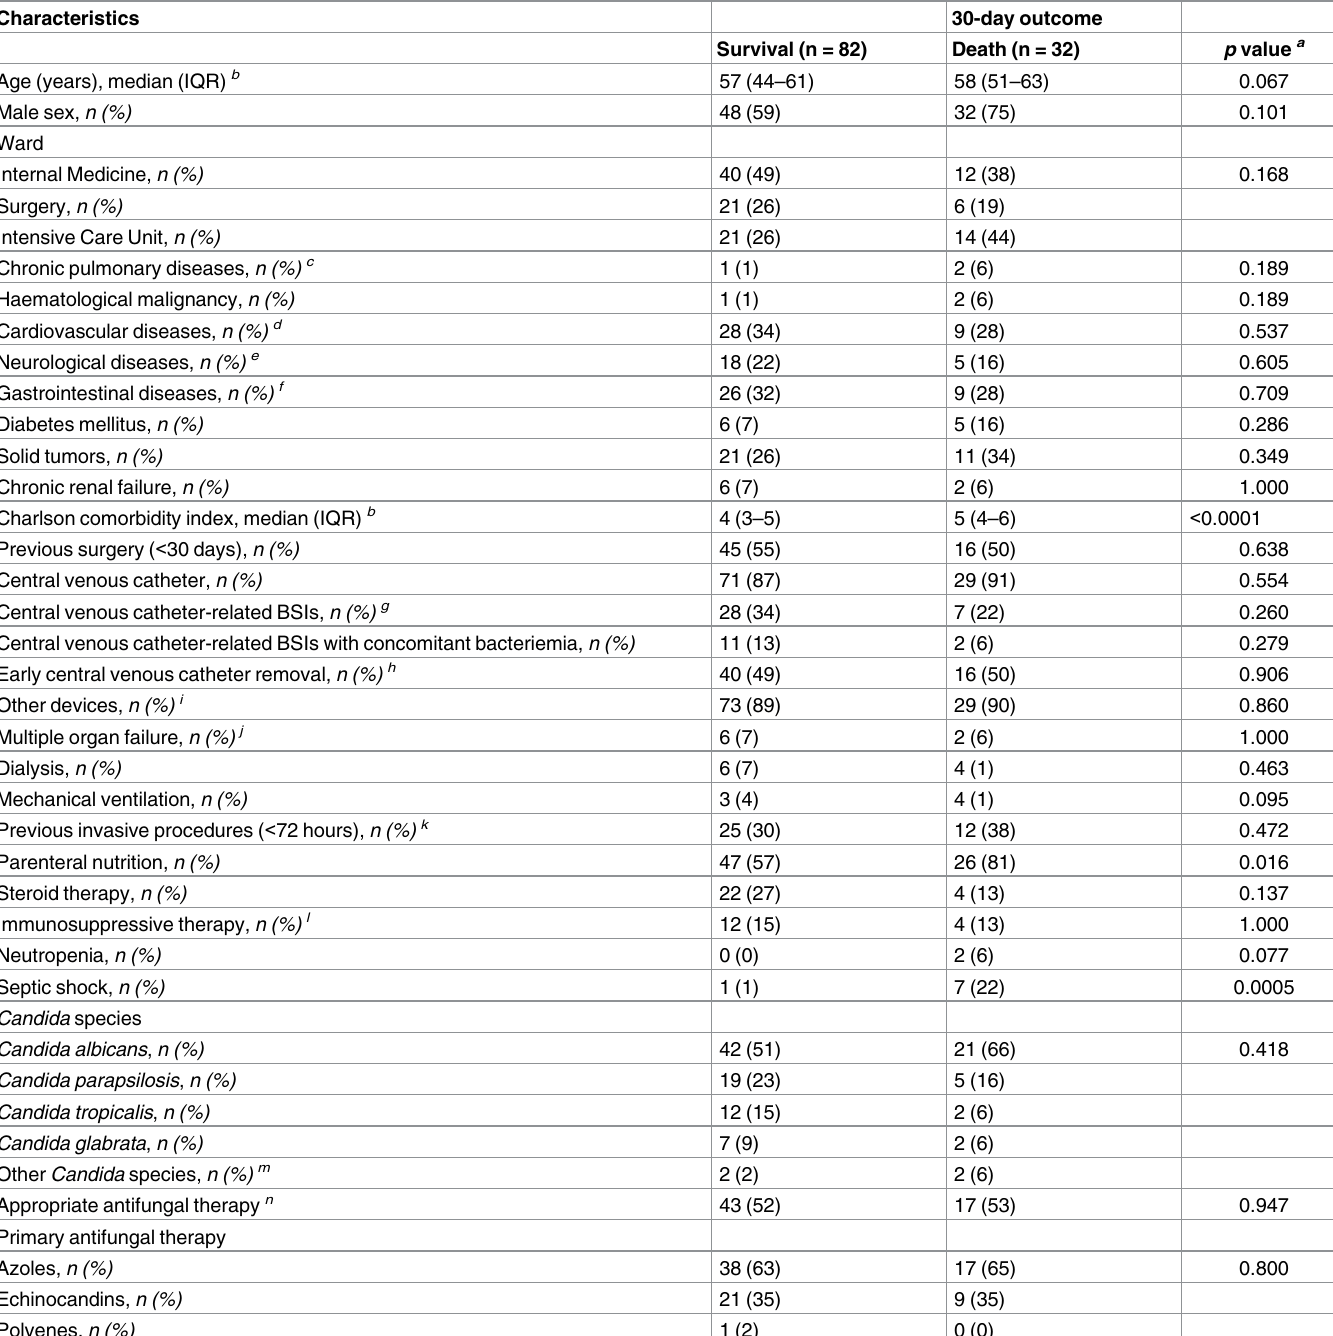
Table 3. Outcome of 114 younger patients with BSIs due to Candida species considered in this study.